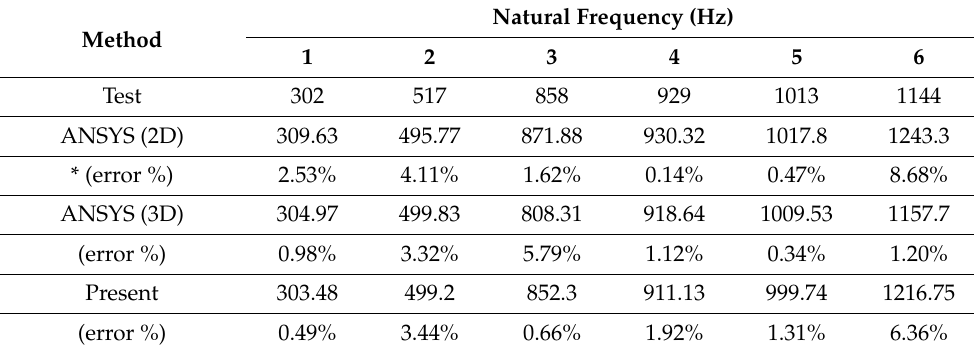
Table 7. Natural frequencies of carbon/epoxy [0 ◦ ] 332 composite cantilever plate ( a / b = 1.88, a / h = 5.15).